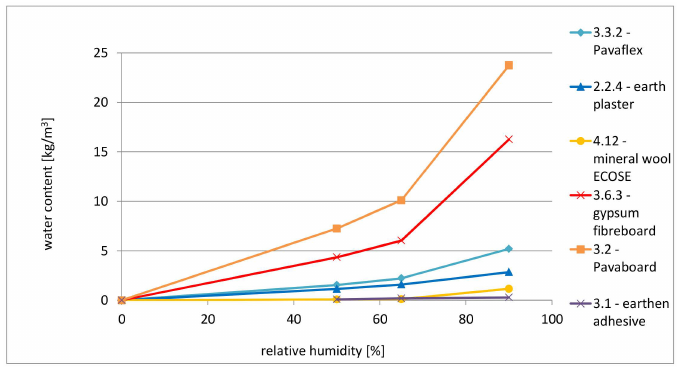
Figure 2. Water content according to relative humidity at 50%, 65% and